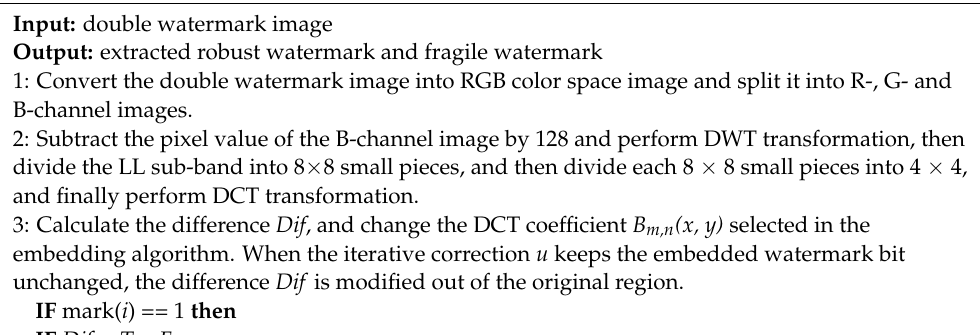
Algorithm 4: Destroy Robust